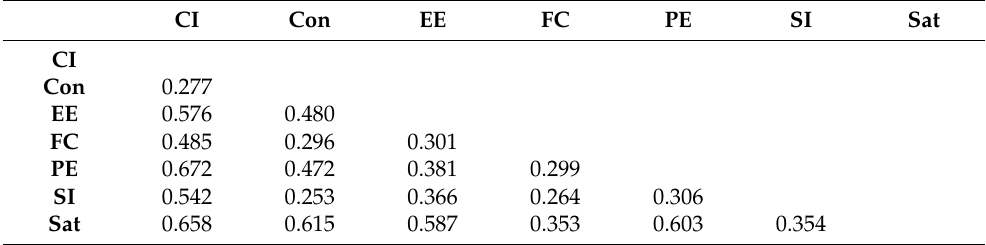
Table 4. Heterotrait-Monotrait Ratio (HTMT).